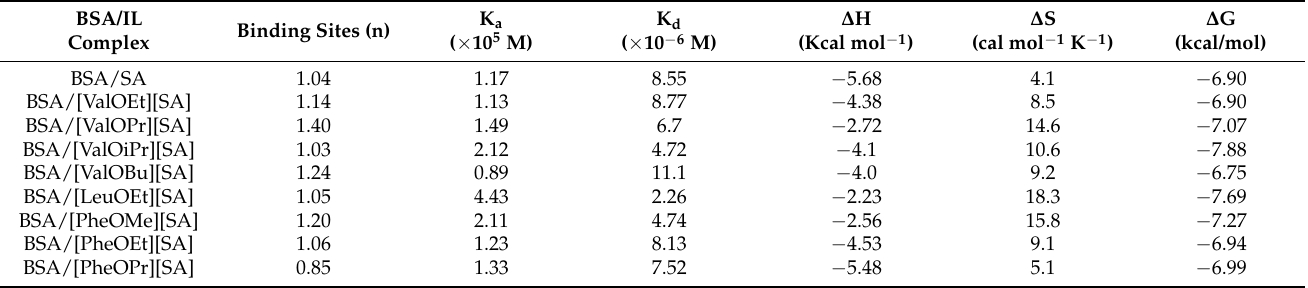
Values of each parameter listed in the table are average in two to three independent